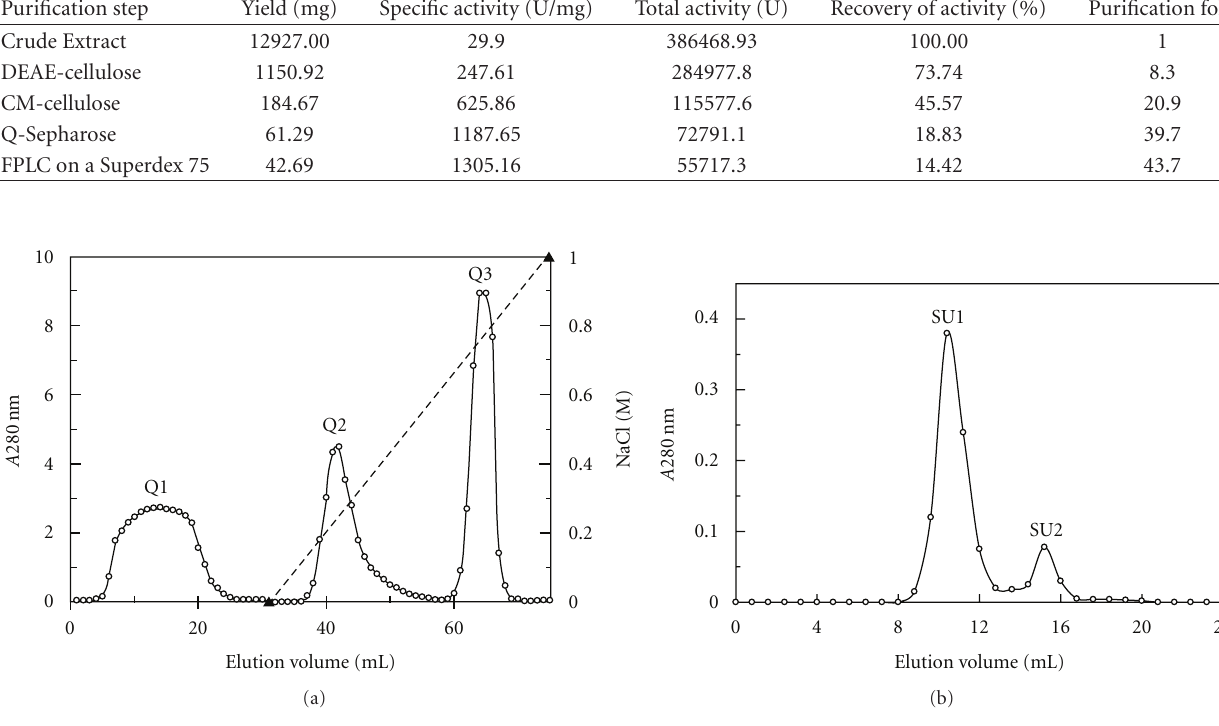
Figure 1: Elution profiles of A. placomyces laccase. (a) Ion exchange chromatography on Q-Sepharose column. Fraction Q2 is the laccase active fraction. (b) Gel filtration on Superdex 75. Fraction SU1 represents purified laccase.